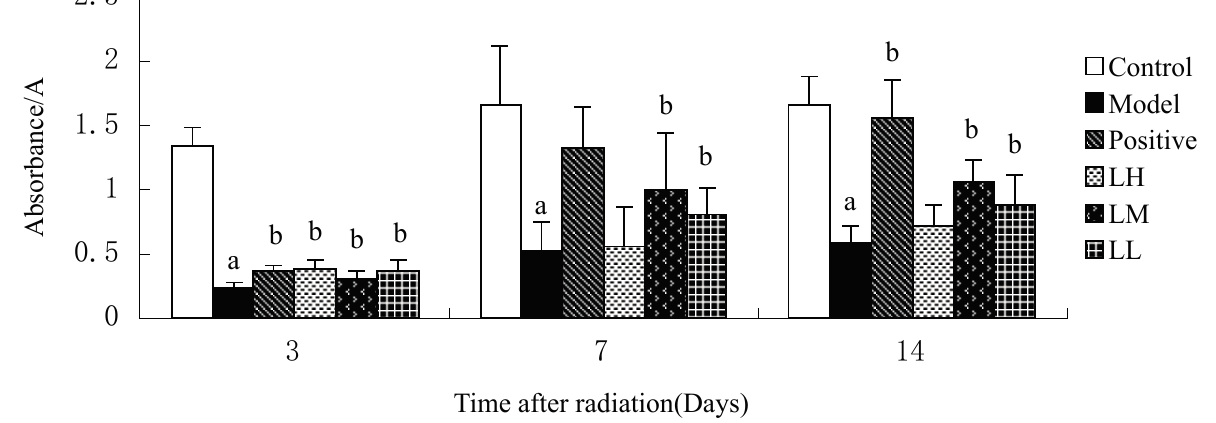
Figure 5. Effect of Lycium ruthenicum Murr. on the DNA content of mice after radiation. n = 10, mean ± SD. a p < 0.05 vs. control group, b p < 0.05 vs. model